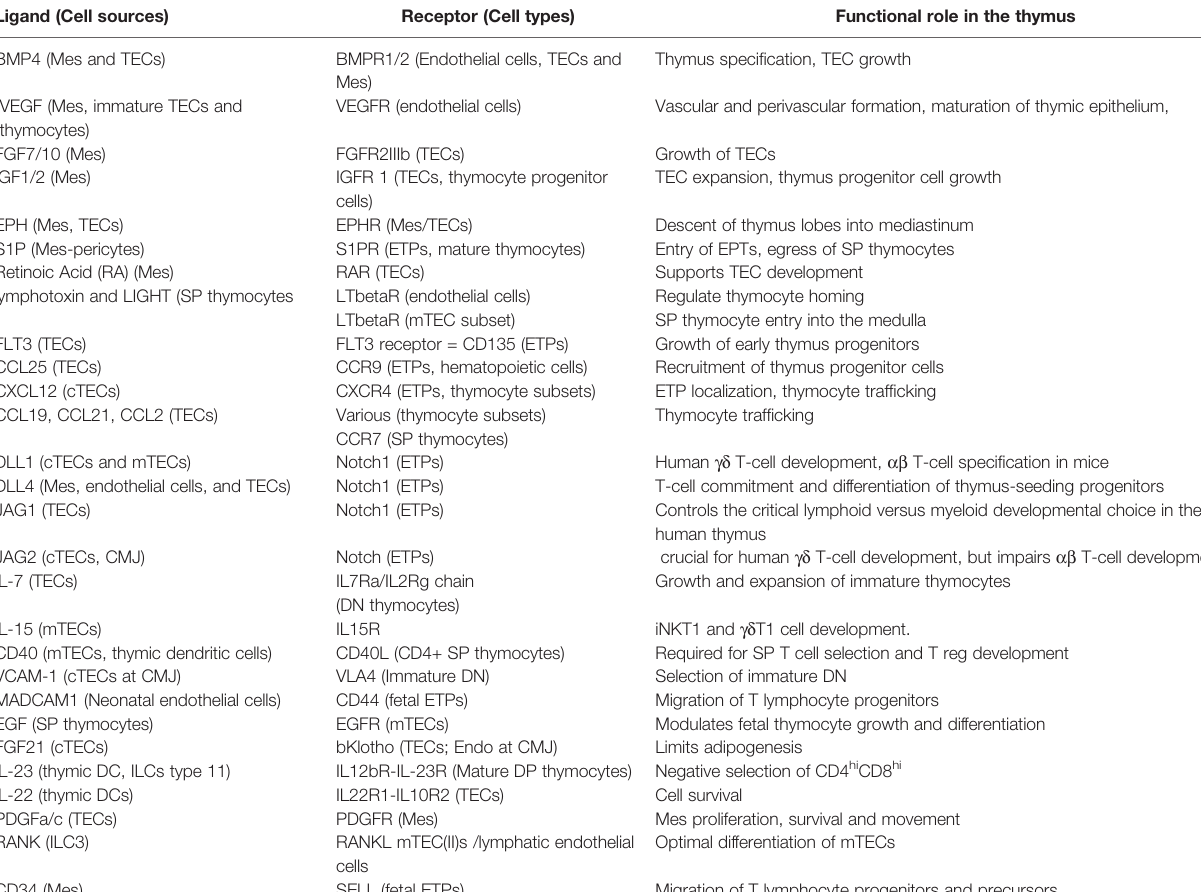
TABLE 1 | Ligand/Receptor interactions supporting T cell